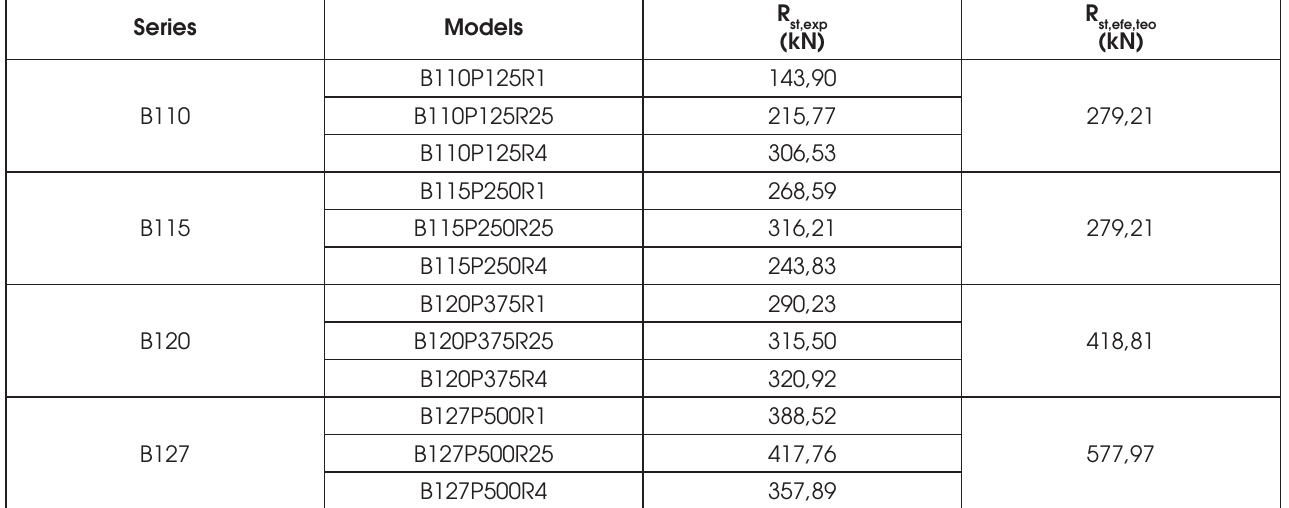
Force R calculated on the strut reinforcement st